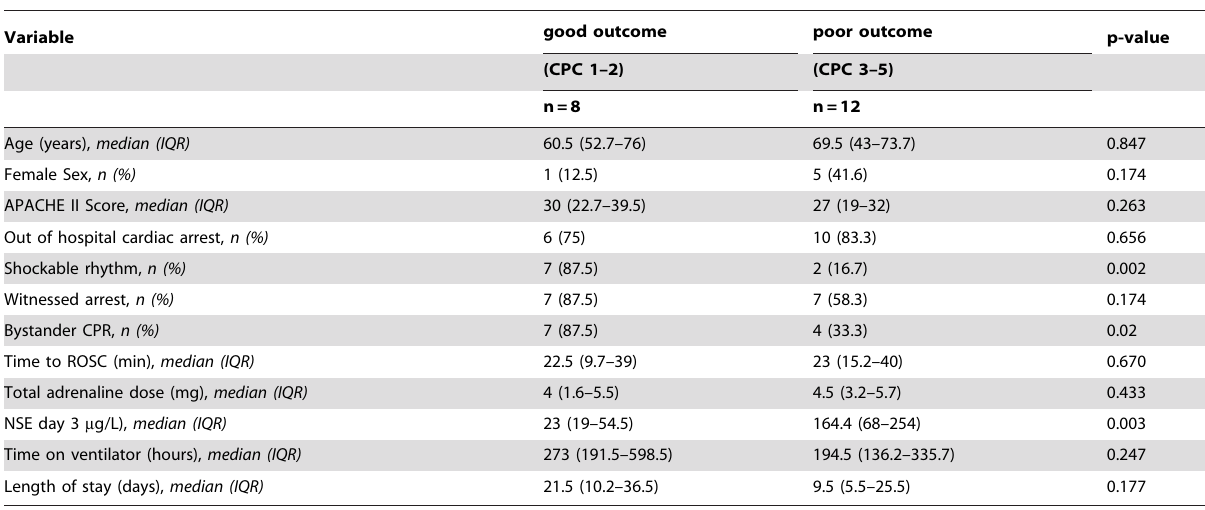
Table 1. Baseline